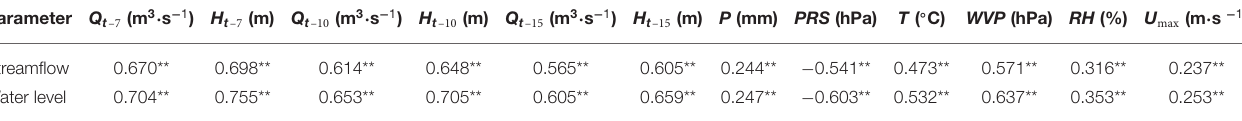
TABLE 1 | Correlation of input parameters with mean streamflow and mean water level of Wuzhou